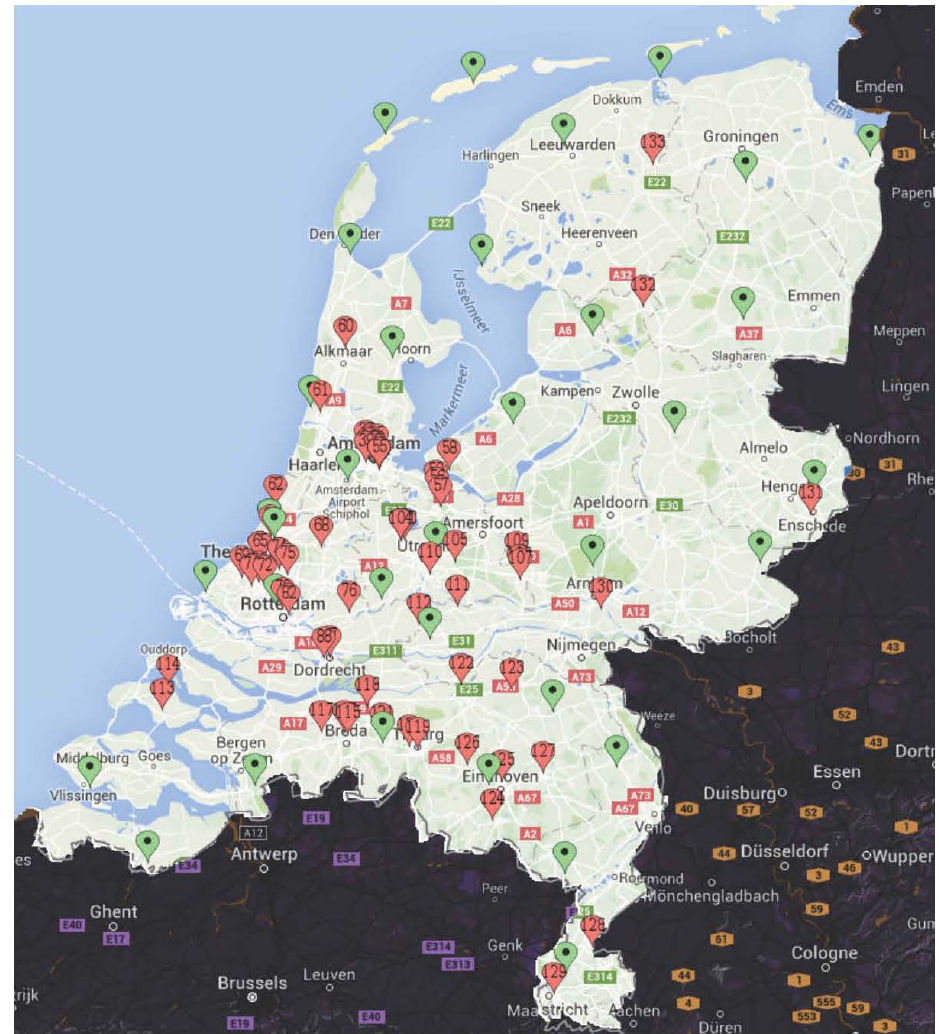
Figure 5. Location of houses and weather stations. Each red pin depicts the location of a house in our dataset. In addition, green pins show the location of weather stations, which are used to find the outdoor